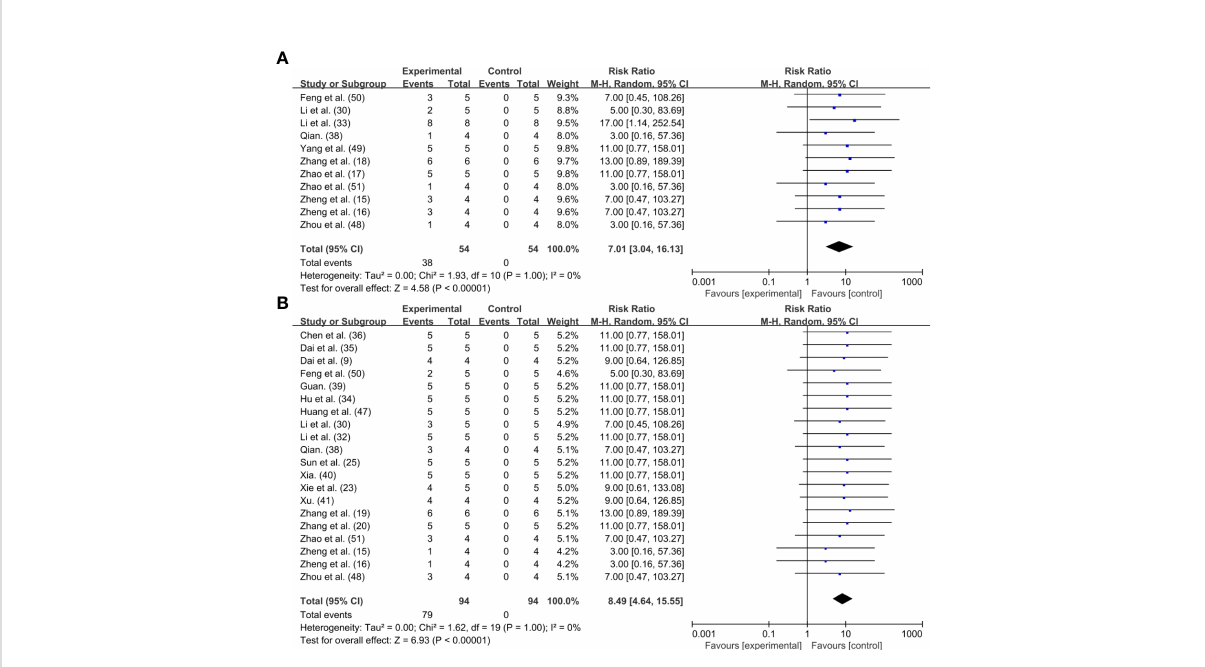
FIGURE 3 Forest plot for PTT effect: (A) Tumor disappeared completely; (B) Tumor shrank but did not completely